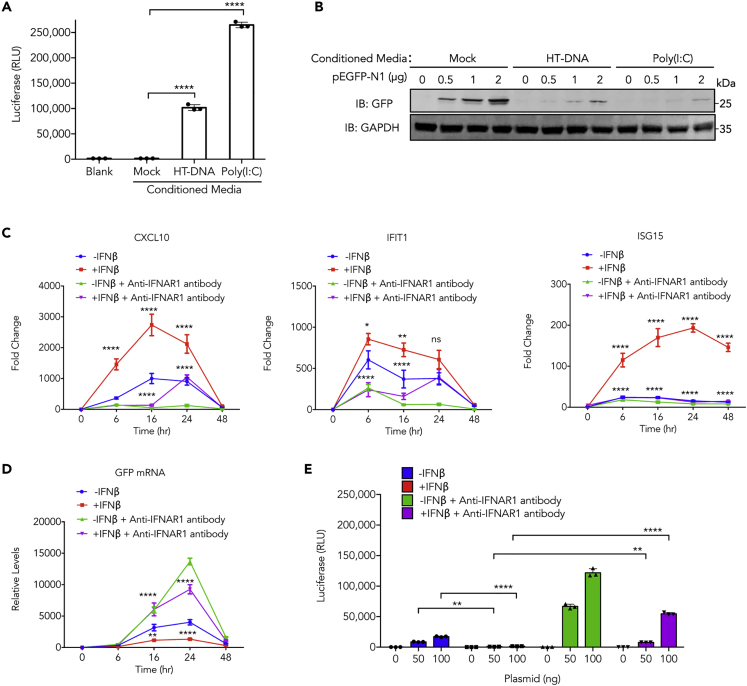
Effects of Interferon on Expression of Exogenous Genes(A) Measurement of interferon activity in conditioned media using Raw-ISG-luc cells. Data represent mean ± SEM. ∗∗∗∗p < 0.0001 by one-way ANOVA versus Mock with Dunnett's correction.(B) L929 cells treated with conditioned media from HT-DNA or poly(I:C) stimulated cells were transfected with indicated amount of pEGFP-N1 plasmid and expression of GFP protein was detected by western blot.(C and D) L929 cells were treated with recombinant IFNβ or anti-IFNAR1 antibody or both, then transfected with pEGFP-N1 plasmid; RNA levels of indicated ISGs (C) and EGFP (D) were measured by RT-qPCR.(E) L929 cells were treated with recombinant IFNβ or anti-IFNAR1 antibody or both, then transfected with pCMV-Renilla plasmid for 20 h, followed by measurement of luciferase activity in cell lysates.In (C)–(E), data represent mean ± SEM of three independent experiments. ∗p < 0.05, ∗∗p < 0.01, ∗∗∗∗p < 0.0001 by two-way ANOVA with Bonferroni's correction, Ns, not significant (significance level, α = 0.05).